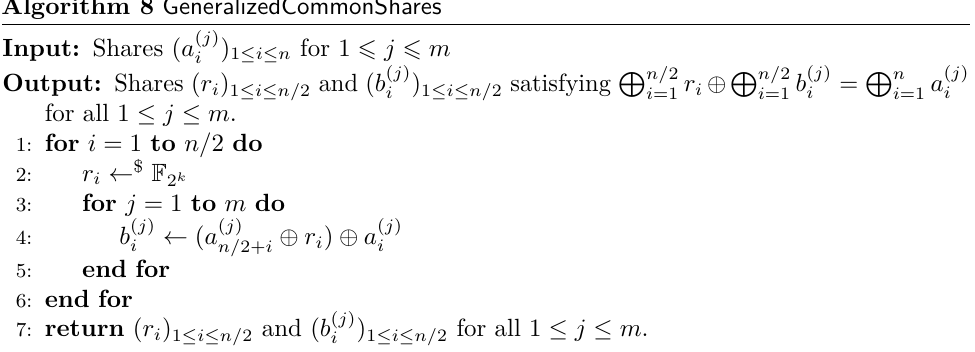
and y ( ‘ ) , for ‘ = { 1 , 2 } . i i